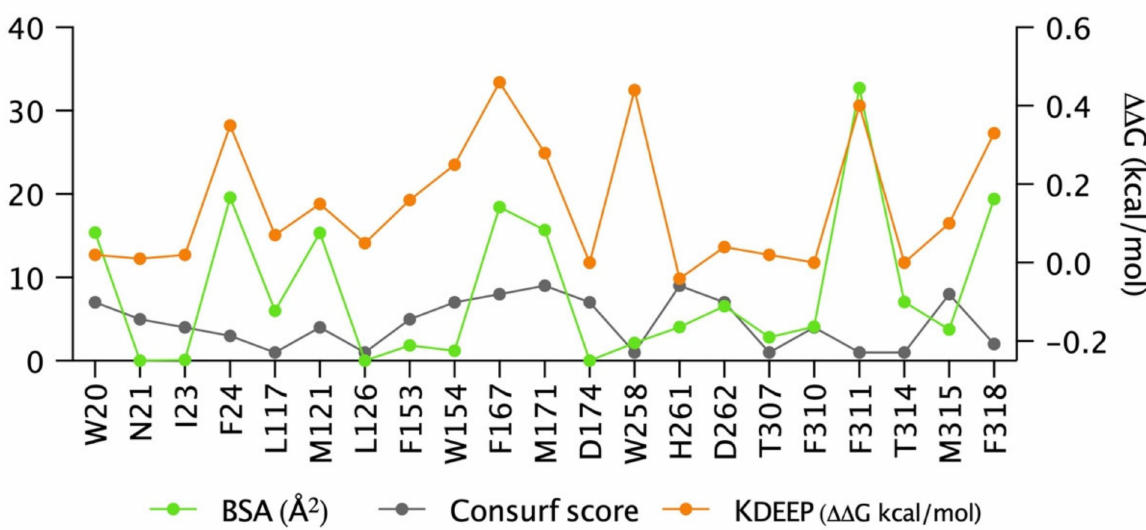
Figure 3. In silico identification of critical residues in the VvROMT substrate-binding site. The binding site was defined to include all residues at 6 Å distance from resveratrol. Buried surface area (BSA, green), ConSurf conservation score (gray), and VvROMT-resveratrol binding affinity (orange) were calculated. BSA of each residue in contact with resveratrol was calculated with dr_sasa software. The conservation score was estimated by ConSurf. The KDEEP server was used to evaluate the complex’s interaction affinity ( ∆∆ G) between the wildtype enzyme and the respective alanine variant of each residue. Positive ∆∆ G values indicate a loss of binding affinity for the respective